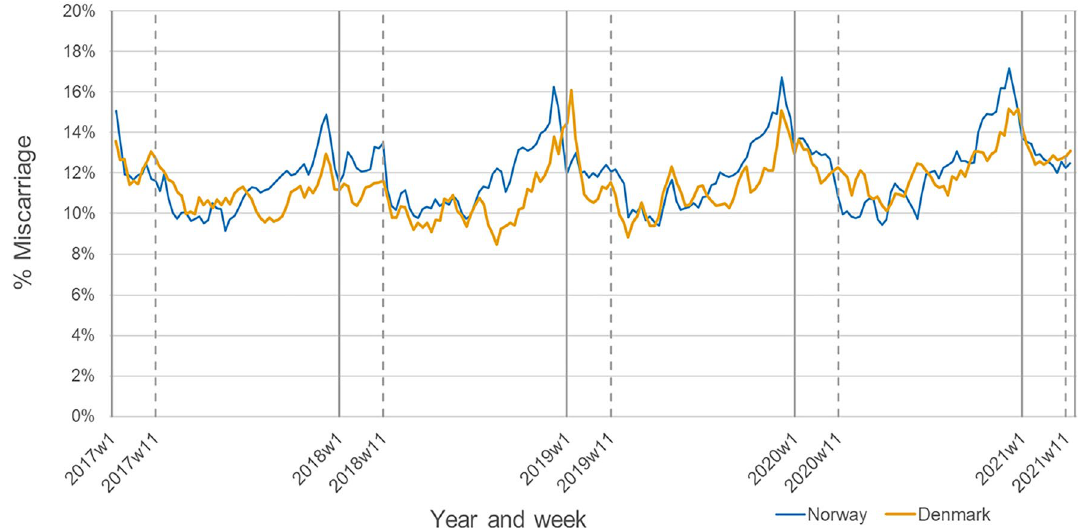
Figure 1. Proportion of pregnancies ending in a miscarriage in Denmark and Norway between January 2017 and March 2021. Calendar week 11 corresponds to the week of March 12th 2020. Sweden was not included in the analysis because the Swedish Pregnancy Register only includes deliveries after 22 completed gestational weeks.